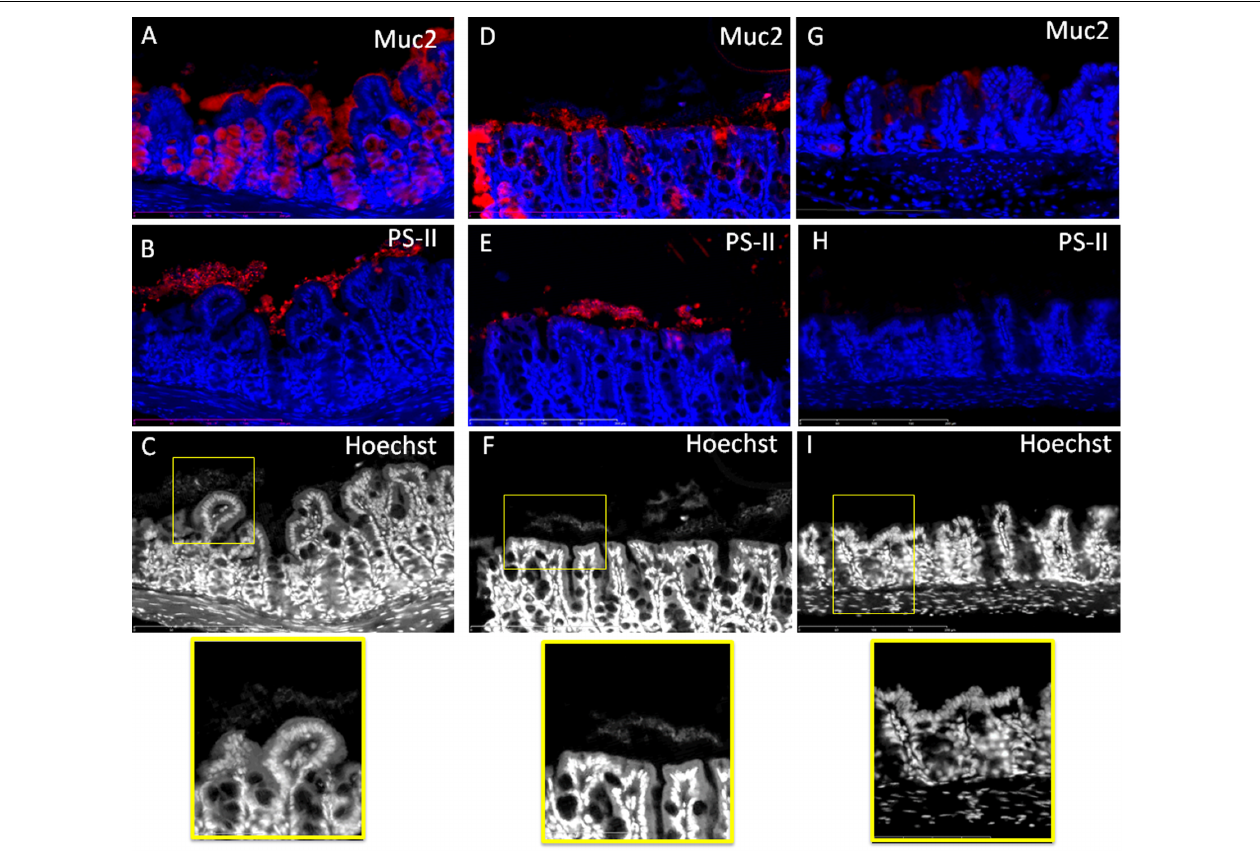
FIGURE 5 | Bacteria localized outside the mucus are embedded in a PSII matrix in the colon of R20291-infected mice. Comparison of stained serial sections (A–C) (D–F) (G–I) . (A,B) and (D,E) Represent two different areas of the colon of mouse infected by the R20291 strain. (G,H) Are serial sections from germ-free mouse. Mucus and PS-II are stained in red and DNA (bacteria and epithelial tissue, extracellular DNA) are stained in blue or gray. The bottom panel is the enlargement of the yellow boxed portion of the image. Scale bar is 200 µ